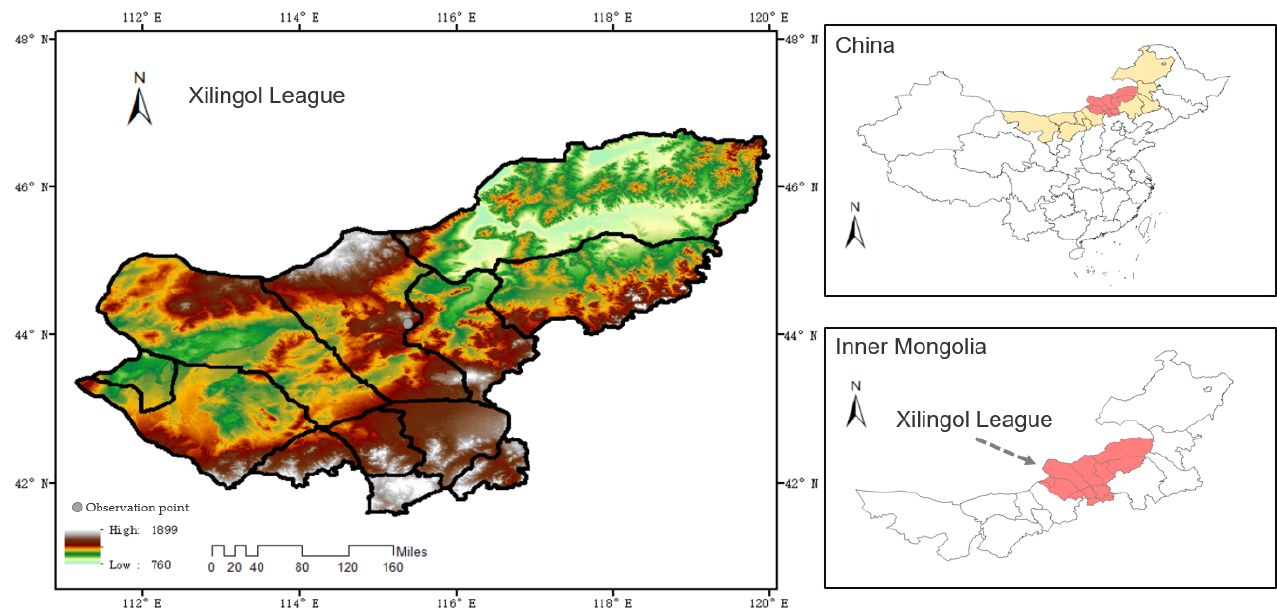
Figure 1. Study area of the Xilingol League grassland. Table 1. Observed values of each variable.